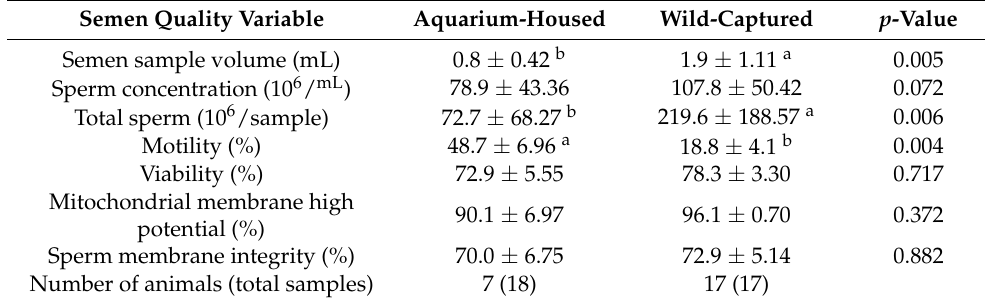
Table 2. Sperm quality comparison for aquarium-housed and wild-captured small-spotted catshark ( Scyliorhinus canicula ). Data are expressed as the mean ± standard